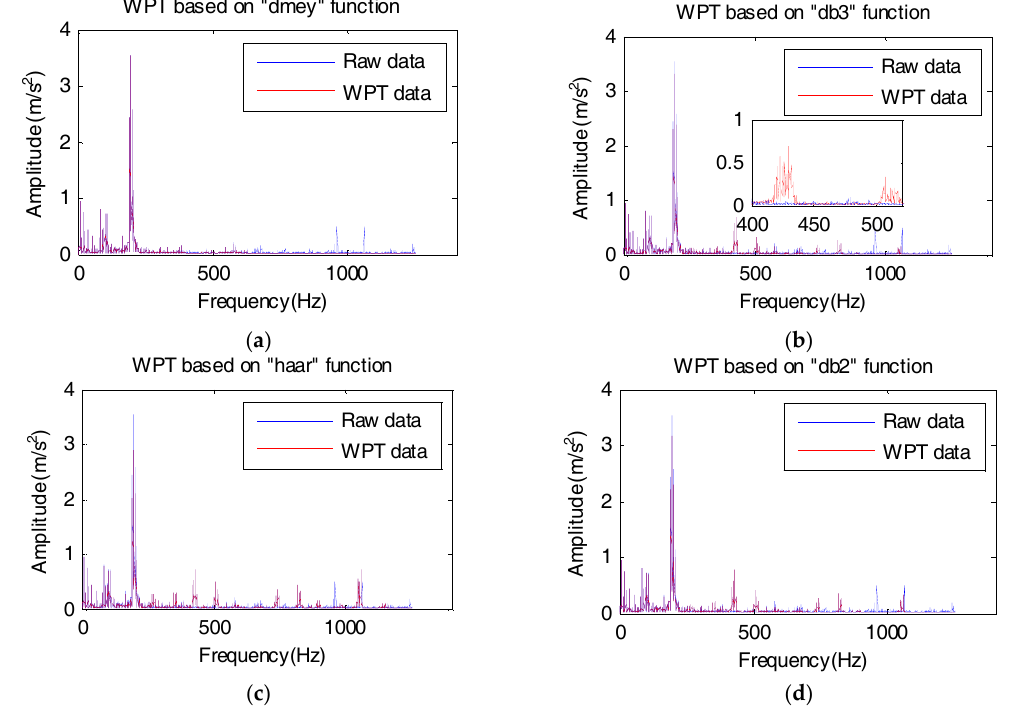
Figure 9. The comparison of the raw data and the reconstructed WPT signal in the frequency domain for different base functions: ( a ) dmey function, ( b ) db3 function, ( c ) haar function, ( d ) db2 function.